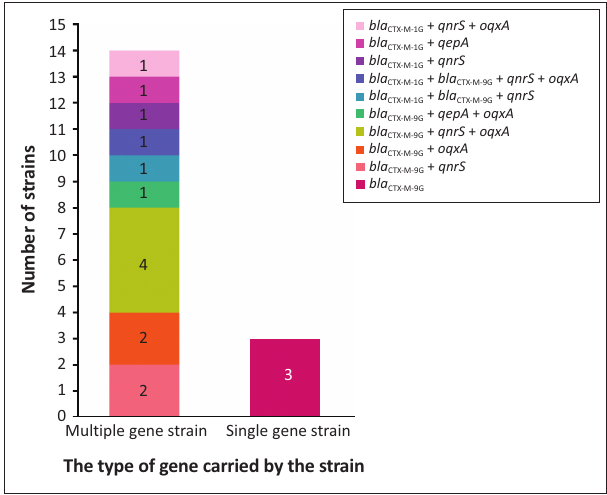
1 Multiple gene strain The type of gene carried by the strain FIGURE 2: Genetic compositions of extended-spectrum β -lactamase strains. Left column: multiple gene strains, Right column: single gene strains.